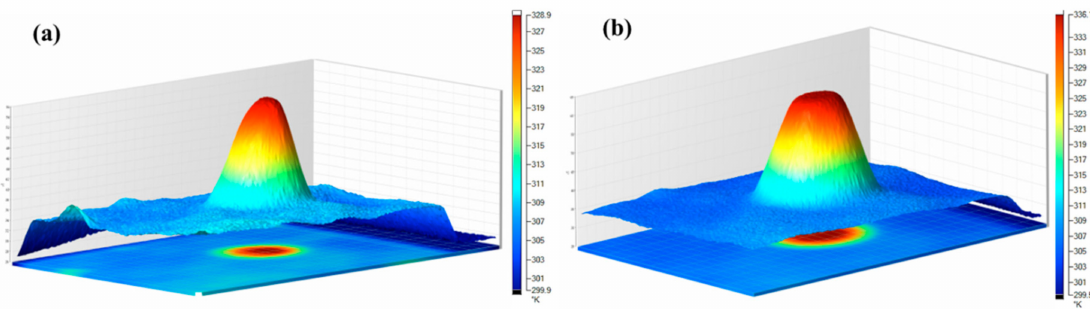
Figure 8. Temperature distribution of the sample. ( a ) the sample heated for 21 s and ( b ) 105